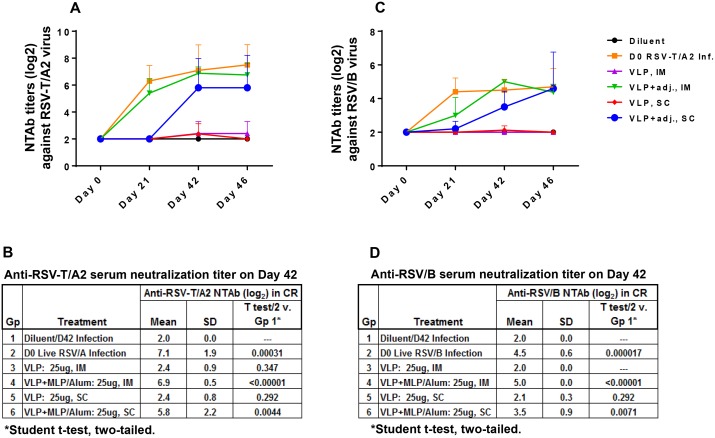
CRs immunized with adjuvanted RSV VLPs induce strong NtAb response to RSV/A2, and RSV/B virus.
A and C: Show NtAb response (mean ± SD) against RSV-T/A2 and RSV/B respectively on stated days. The same figures show that VLPs alone induced NtAb response in only some of the animals and only weakly. B and D: Show neutralizing antibody response (mean ± SD) on day 42 against RSV-T/A2 and RSV/B respectively. Statistical difference between Gp 1 vs all other groups individually is also tabulated.